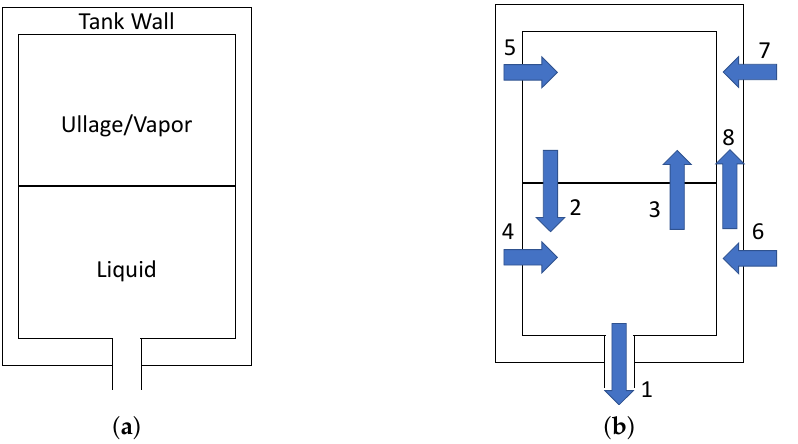
Figure 2. Diagram showing the nodes ( a ) and the heat and mass transfer process between the phases ( b ). All the models share the same governing equations for mass and energy